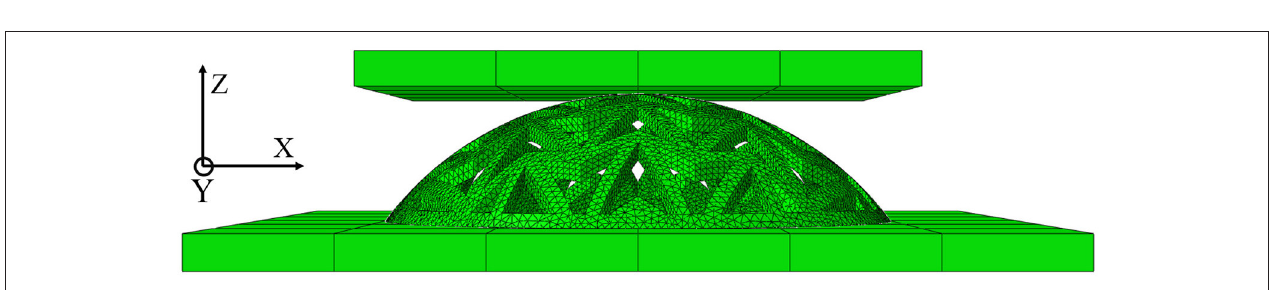
FIGURE 6 | Schematic of the FE dome compression